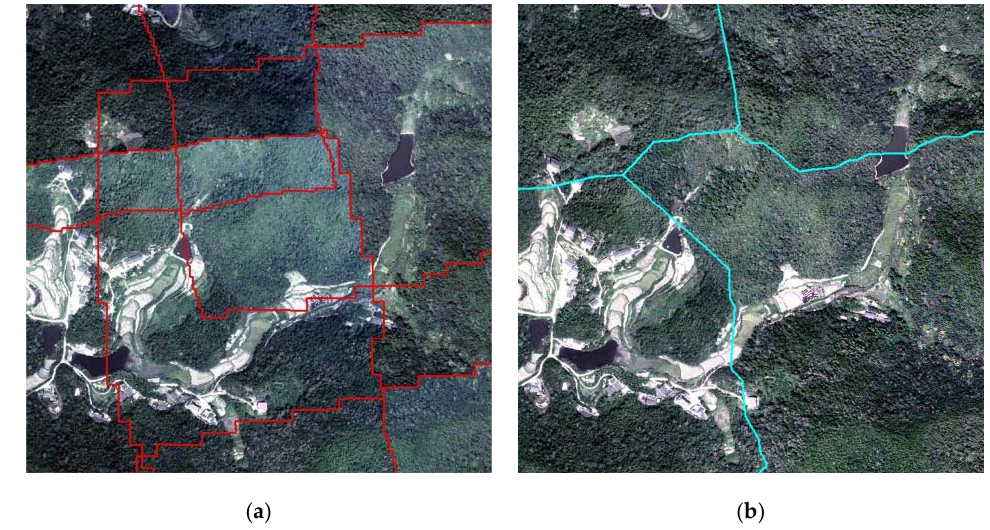
Figure 7. Details of ( a ) the blue rectangular area marked in Figure 5; ( b ) the blue rectangular area marked in Figure 6.